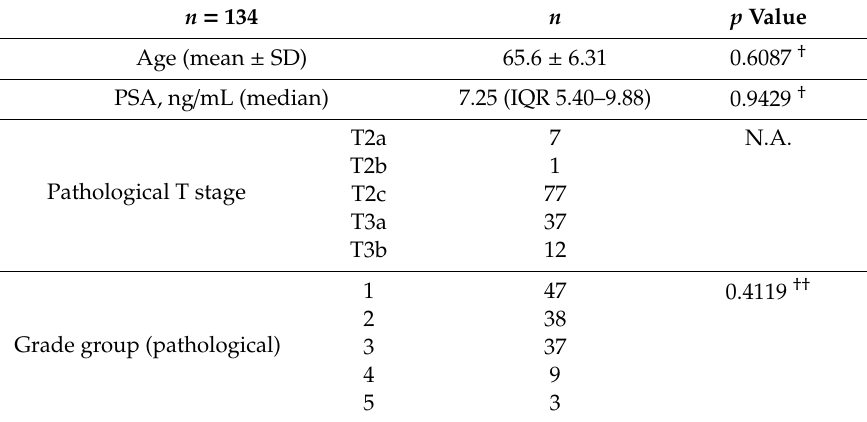
Figure 2. Difference of AKR1C3 immunostaining score between benign and cancer epithelia in the same individuals. AKR1C3 immunostaining was significantly stronger in the cancer epithelia than in the benign ones at the same spots ( p < 0.0001, Pearson’s chi-squared test). Table 1. Clinicopathological features of tissue-microarray (TMA) specimens with both benign epithelium and cancer cells in the same spot.